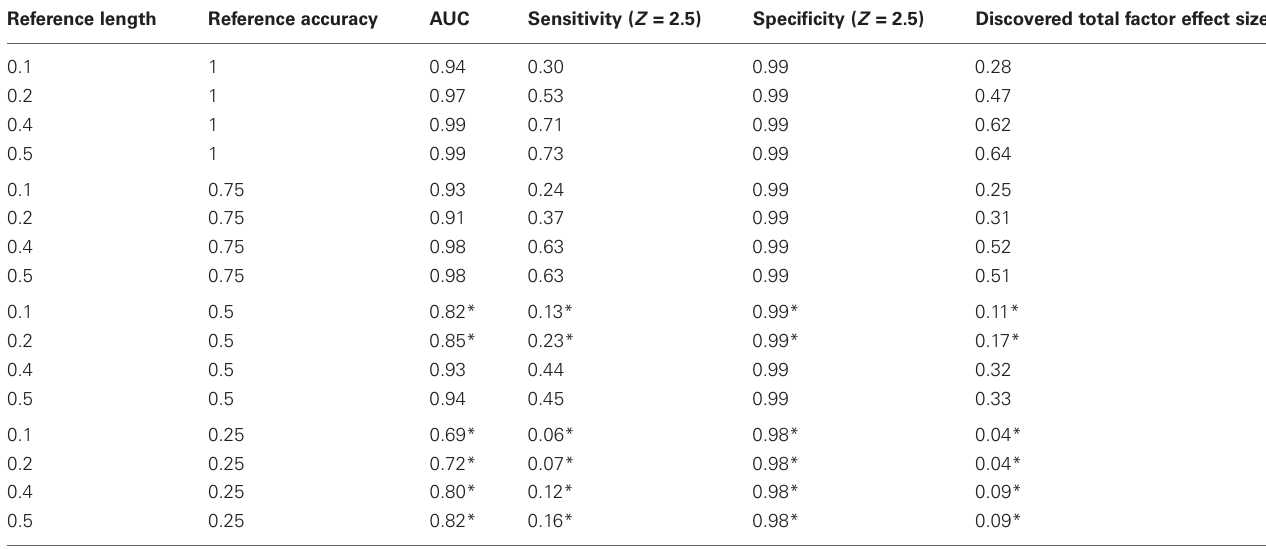
Table 2 | Simulation results using 200subjects and 10,000